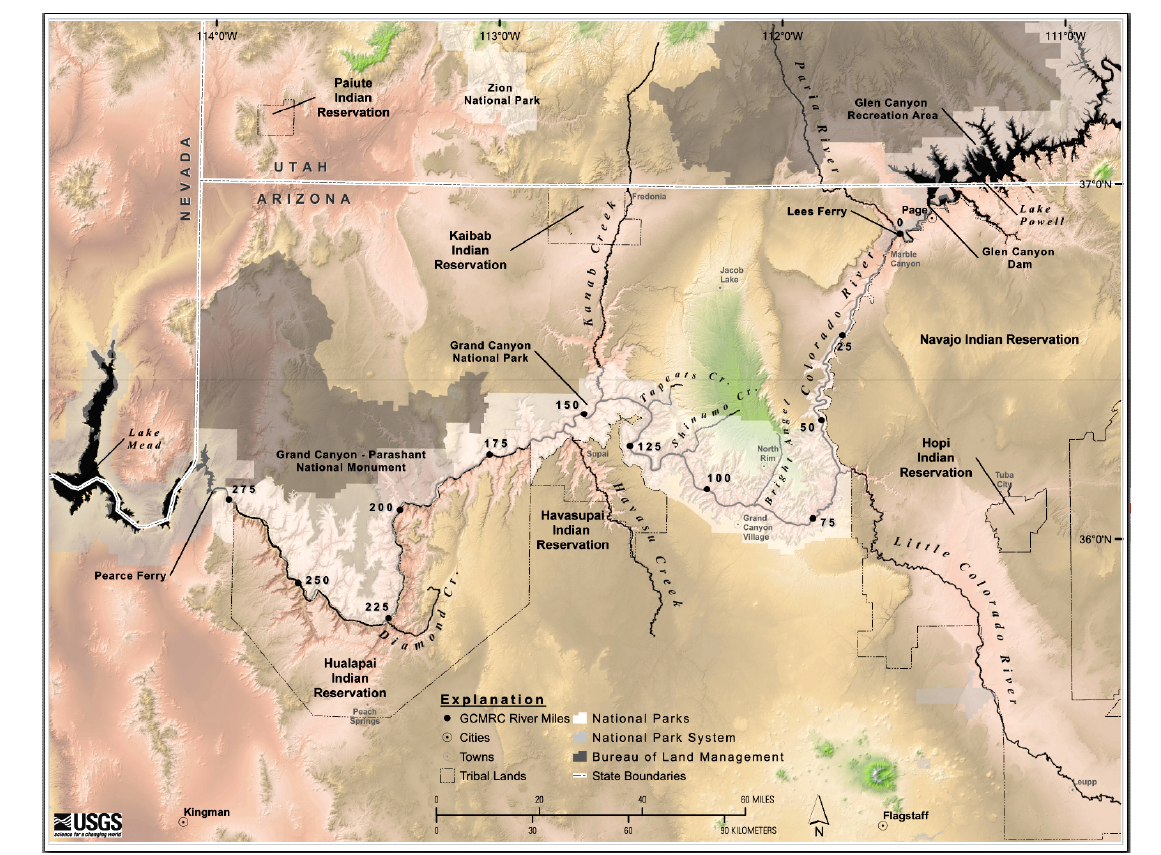
Fig. 1 . Spatial setting of the Glen Canyon Dam Adaptive Management Program and the Colorado River ecosystem. Monitoring and research activities extend downstream from the forebay of Glen Canyon Dam to the western boundary of Grand Canyon National Park at Lake Mead, with numbers along river indicating distance in kilometres downstream from Glen Canyon